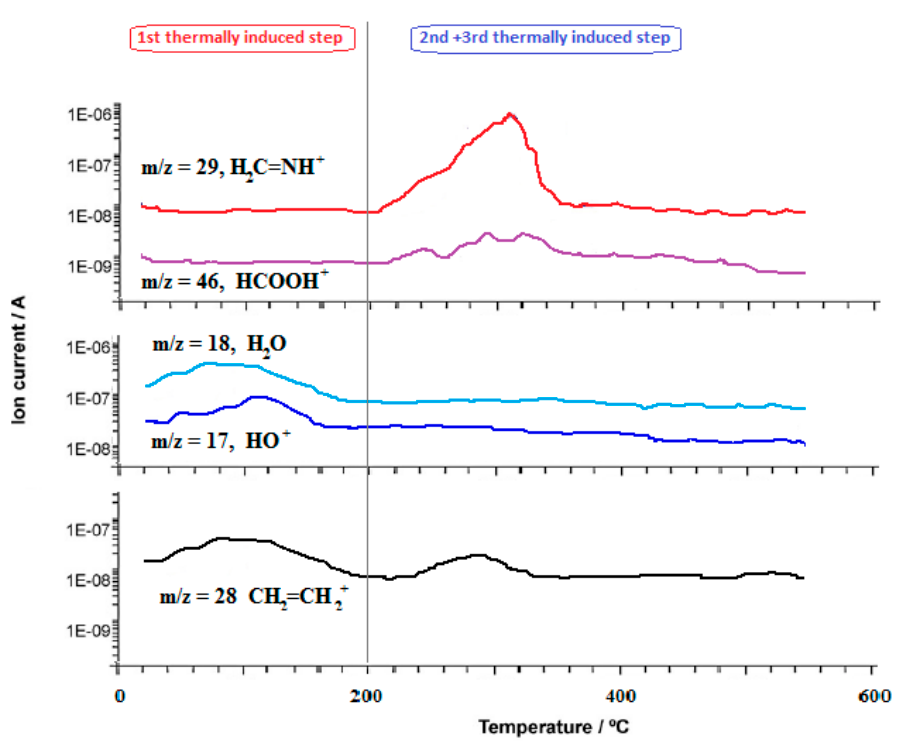
Figure 2. Representative curves of Thermally Induced Evolved Gas Analysis by Mass Spectrometry: m / z traces commonly recorded as a function of the temperature for all the analyzed complexes.